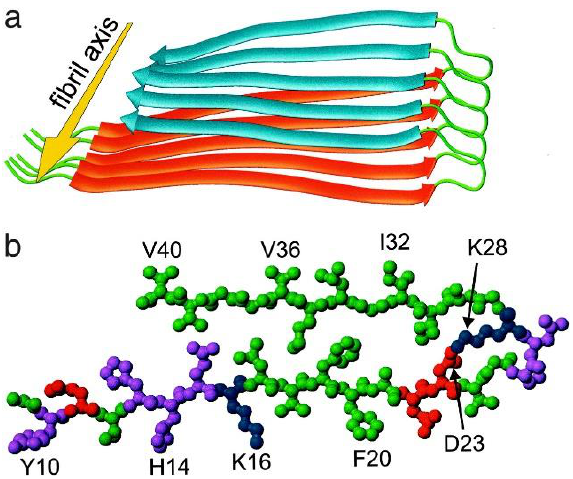
Figure 1. Structural model for Aβ40 fibrils, consistent with solid-state NMR constraints on the molecular conformation and intermolecular distances and incorporating the cross-β motif common to all amyloid fibrils [17]. Residues 1–8 are considered fully disordered and are omitted. ( a ) Schematic representation of a single molecular layer or cross-β unit. The yellow arrow indicates the direction of the long axis of the fibril, which coincides with the direction of intermolecular backbone hydrogen bonds. The cross-β unit is a double-layered structure, with in-register parallel β-sheets formed by residues 12–24 (orange ribbons) and 30–40 (blue ribbons). Mass-per-length measurements from electron microscopy indicate that fibrils are formed by two parallel cross-β units. ( b ) Central Aβ40 molecule viewed down the long axis of the fibril. Residues are color-coded according to their sidechains as hydrophobic (green), polar (magenta), positively charged (blue), or negatively charged red).